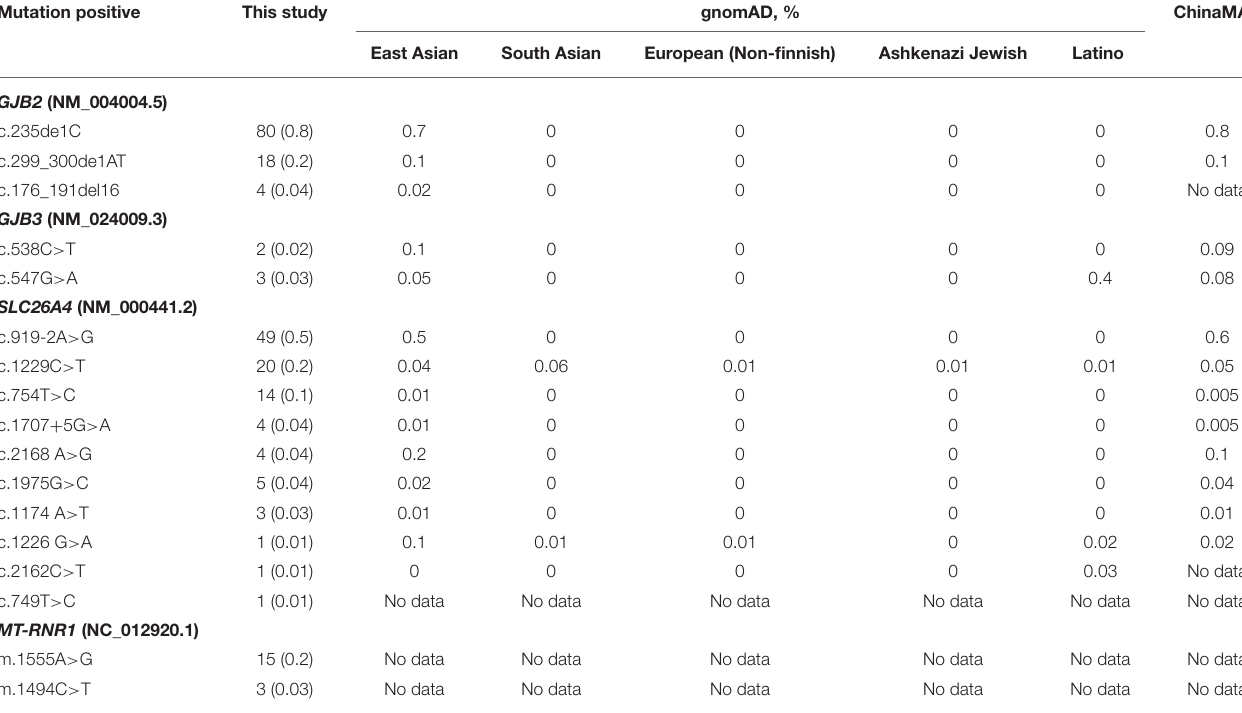
TABLE 4 | Prevalence of hearing loss-associated mutations in this study, genomAD and ChinaMAP. Mutation